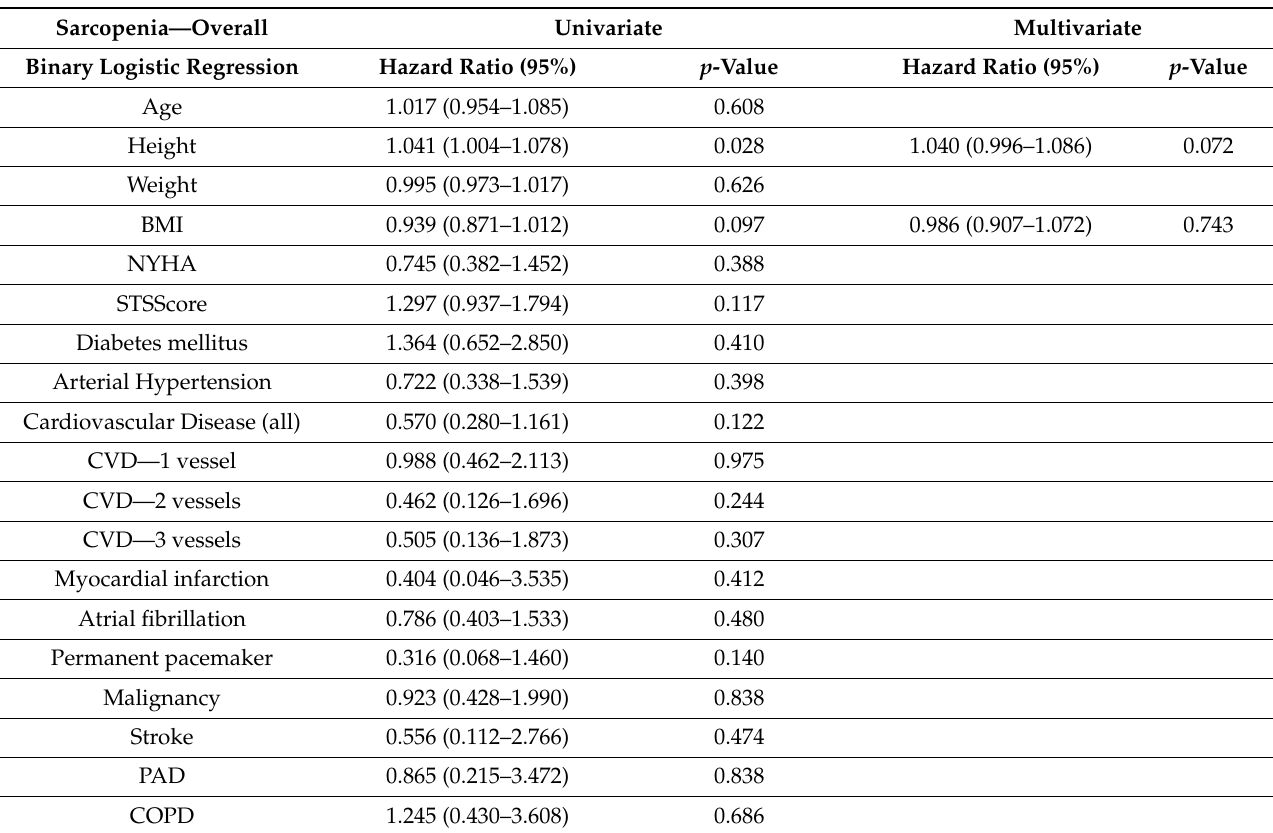
Table 2. Univariate and multivariate binary logistic regression analysis of overall cohort detecting predictors of